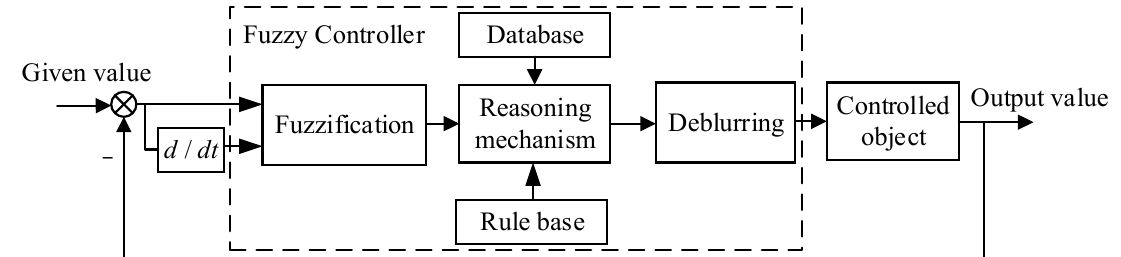
Figure 5. Typical fuzzy control system structure.